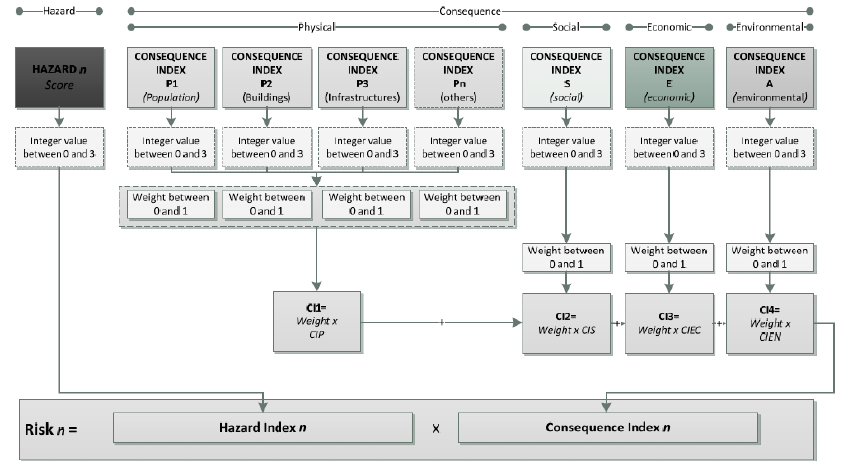
Figure 2. RiskOTe semi-quantitative risk analysis model.